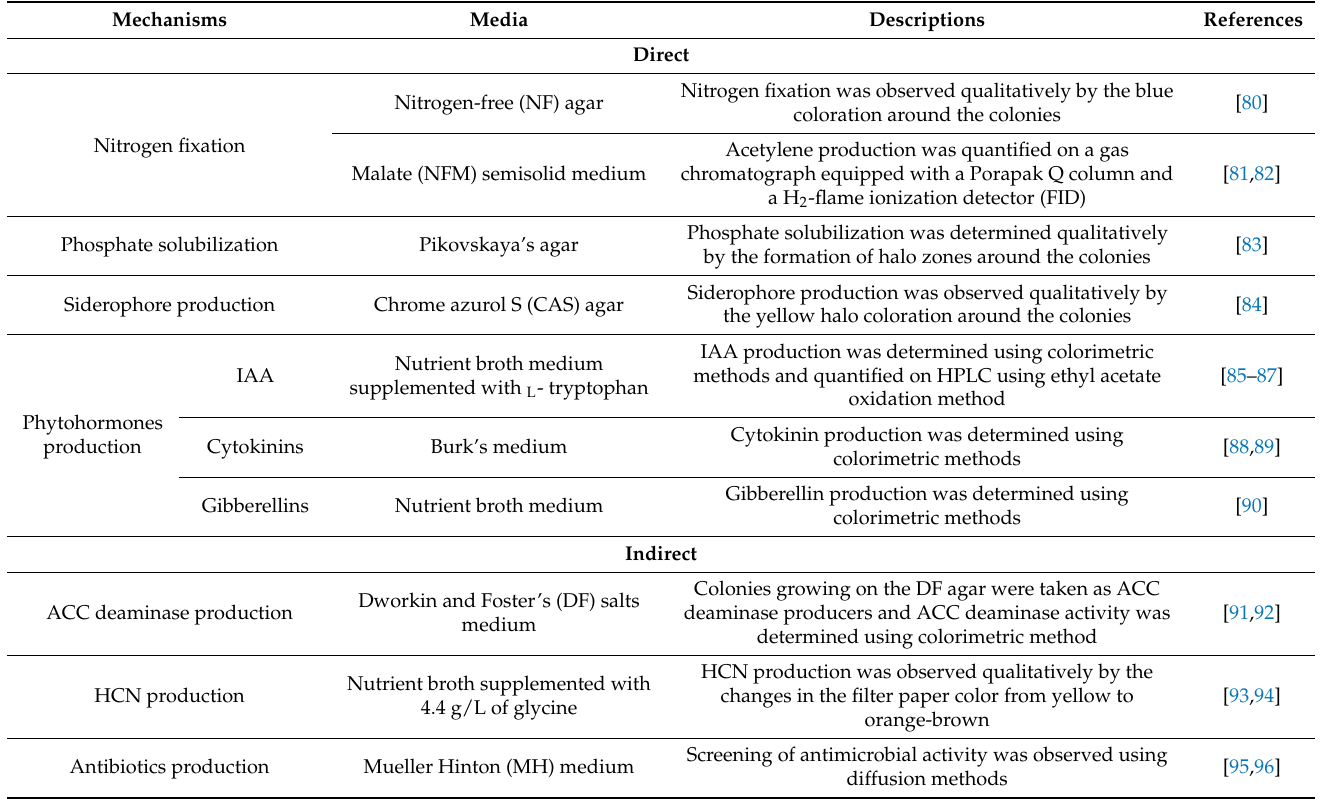
Table 2. In vitro characterizations of promising